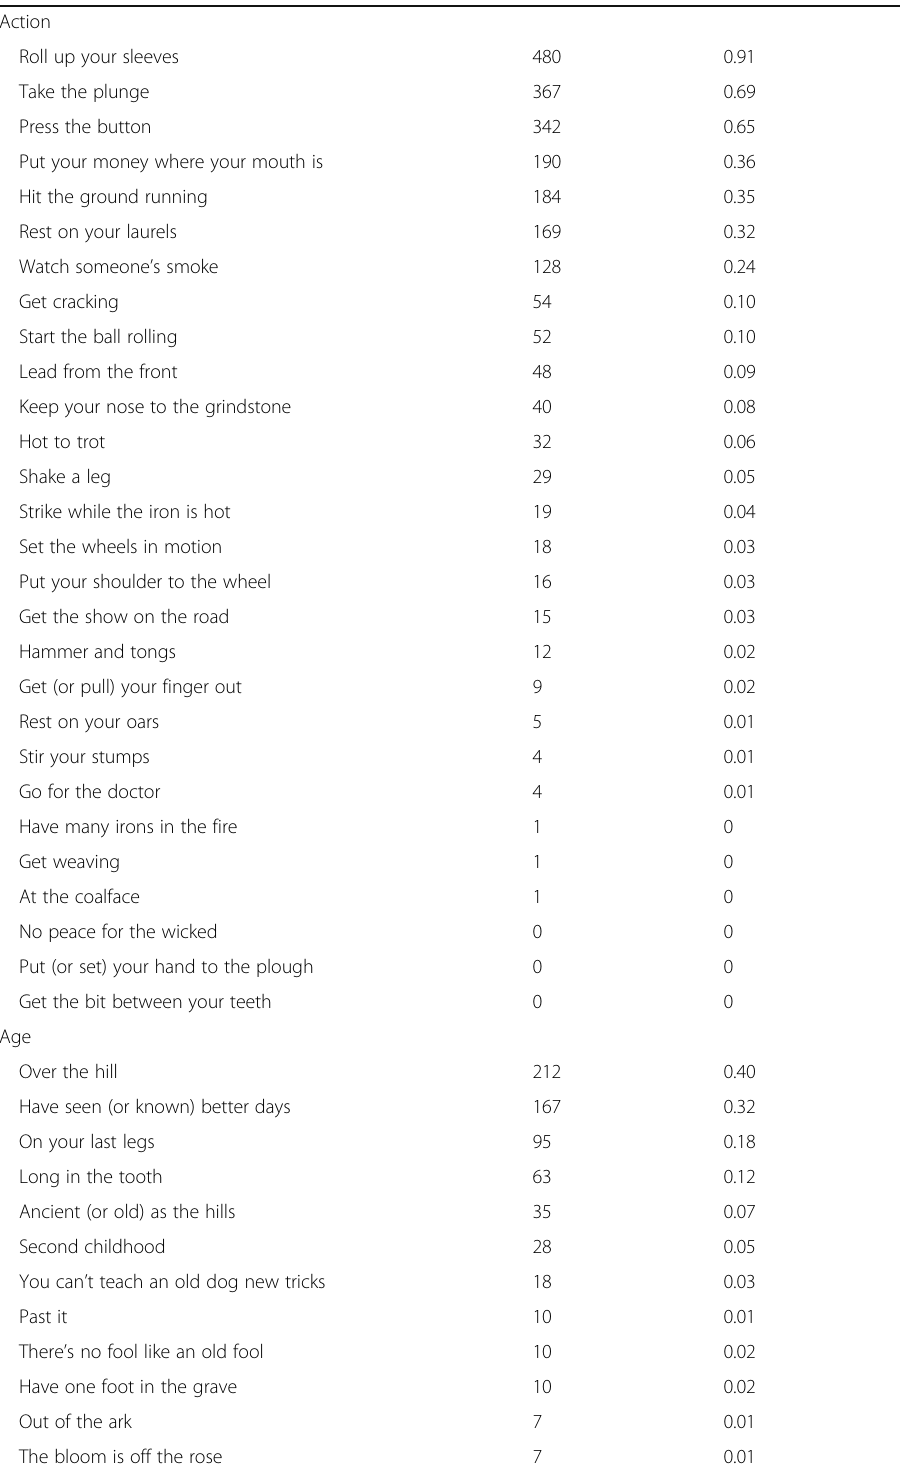
Table 5 Thematic index of Oxford Dictionary of Idioms along with the frequencies per